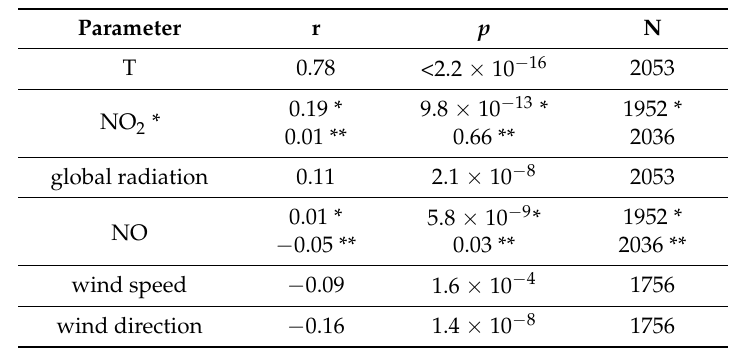
Table 1. Correlation coefficients r (Pearson), p values and number of data pairs N for different meteorological and atmospheric chemistry parameters with ground level ozone volume mixing ratios observed at Schwarzwald-Sued/Black Forest between June and August